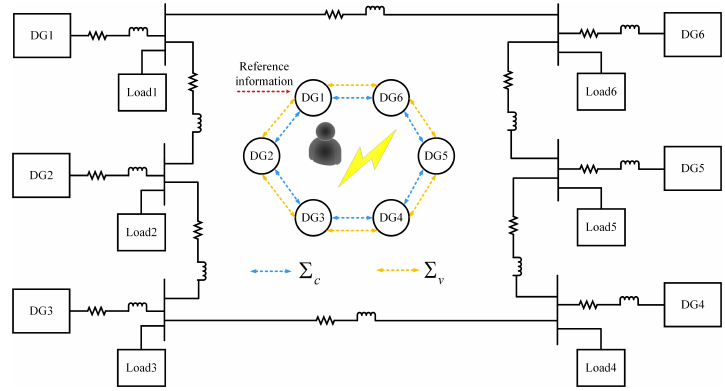
Figure 4. The test seaport microgrid with 6 DGs in this paper.